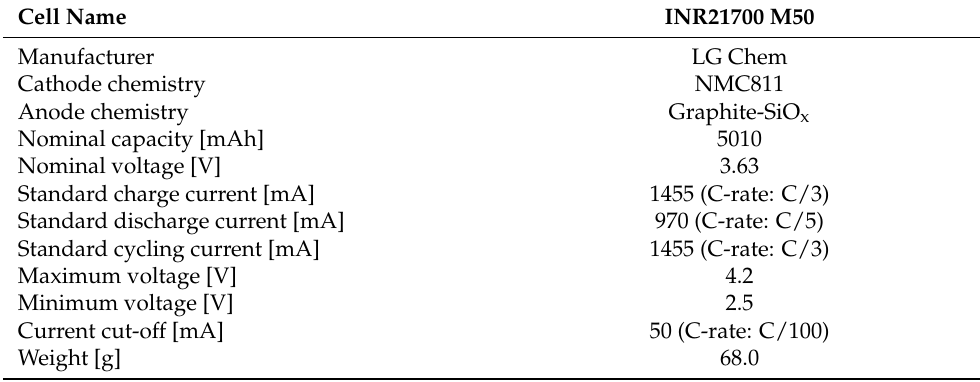
Table 1. Main characteristics of the cylindrical commercial cell under investigation. Current-rate (C-rate) values are calculated with respect to the nominal